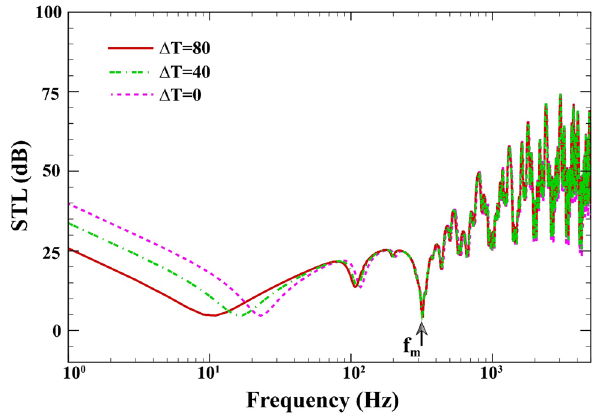
Figure 10. STL of double-walled sandwich composite MEE plate against the temperature rise.